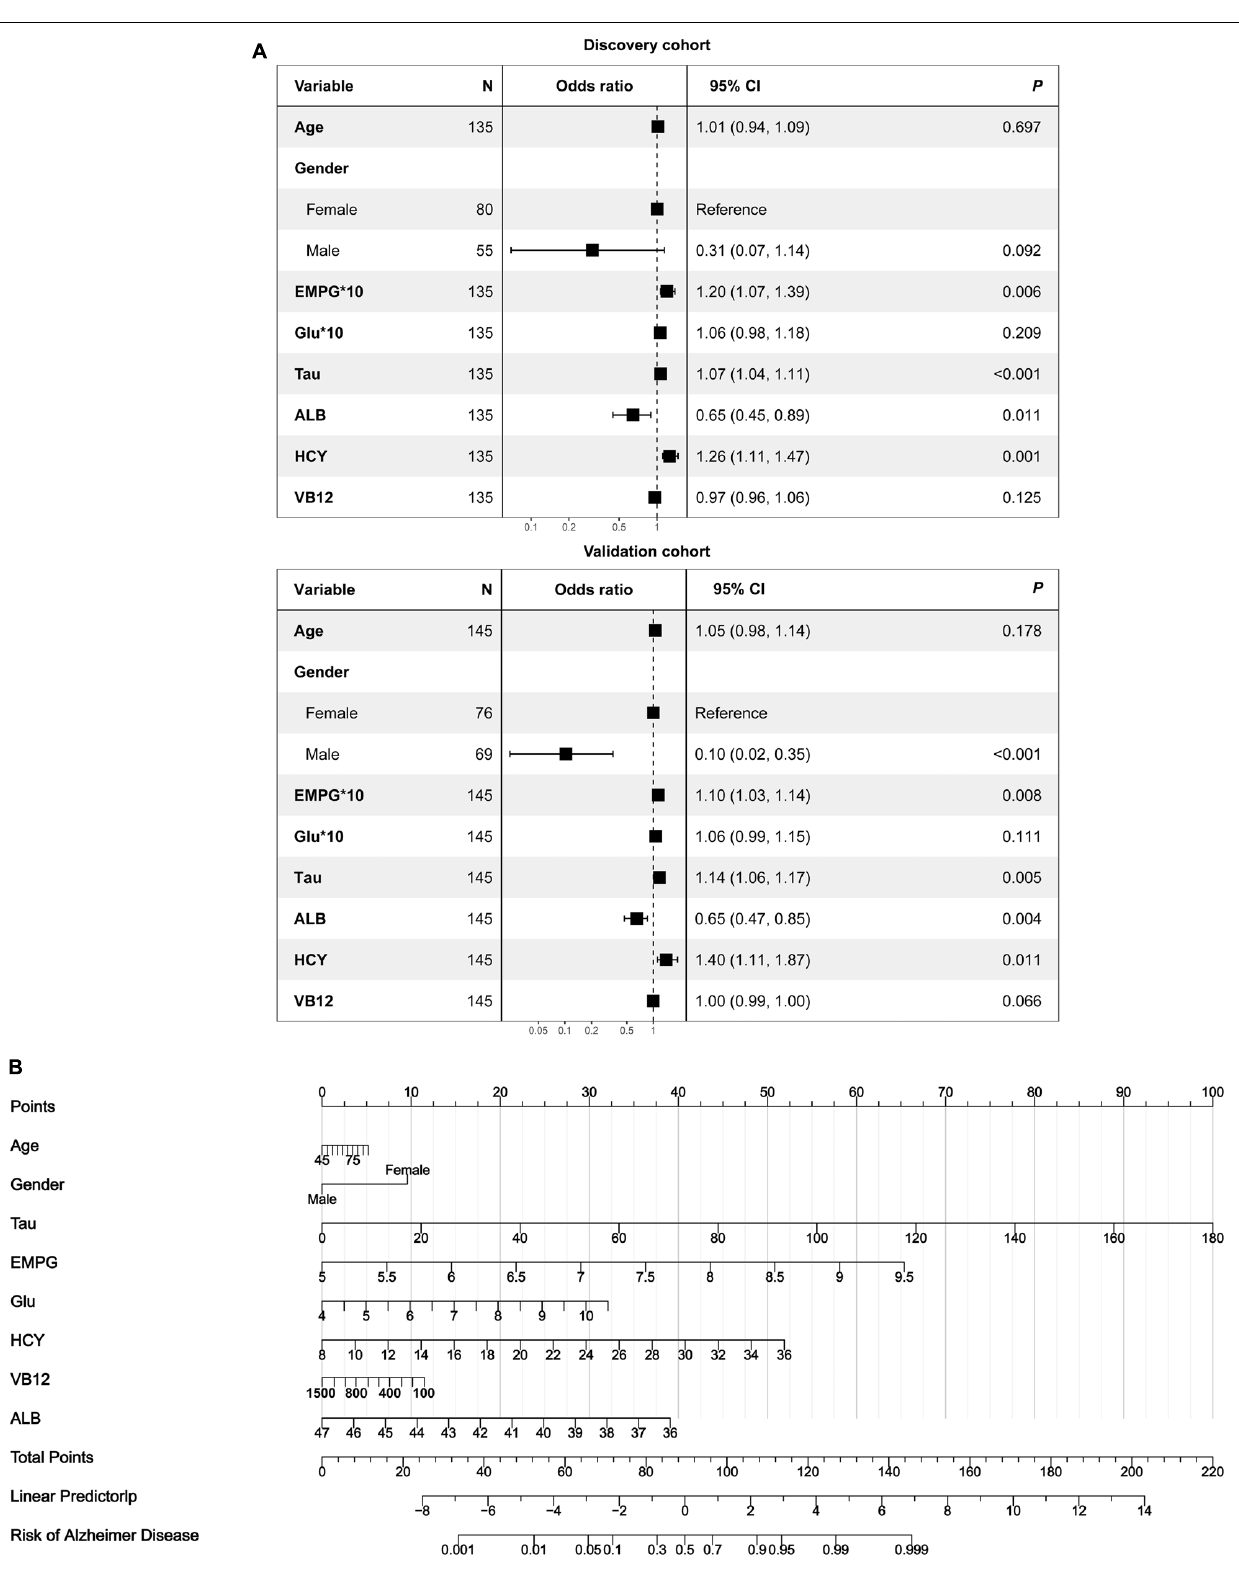
Frontiers in Aging Neuroscience |